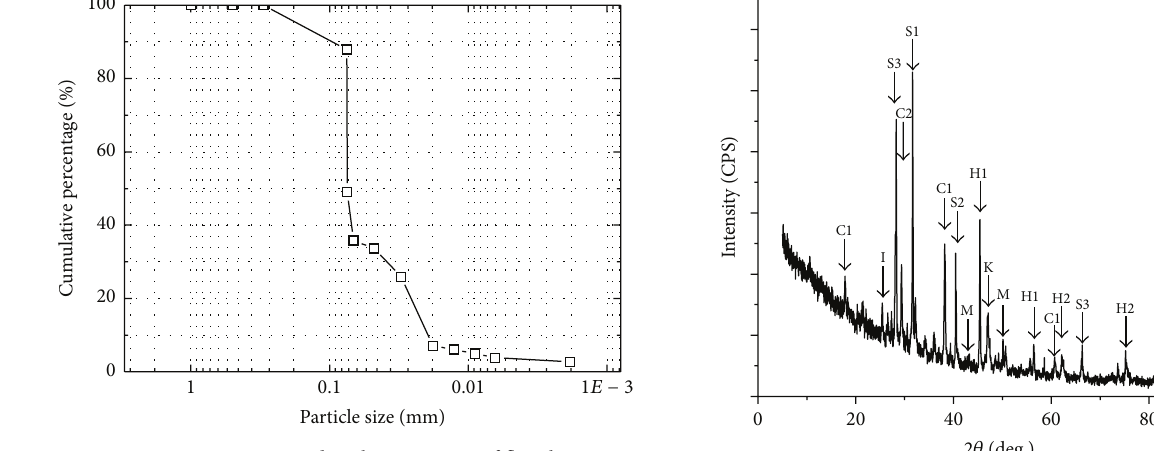
Figure 4: Grain size distribution curve of fly ash. Table 3: Chemical compositions of fly ash and OPC.